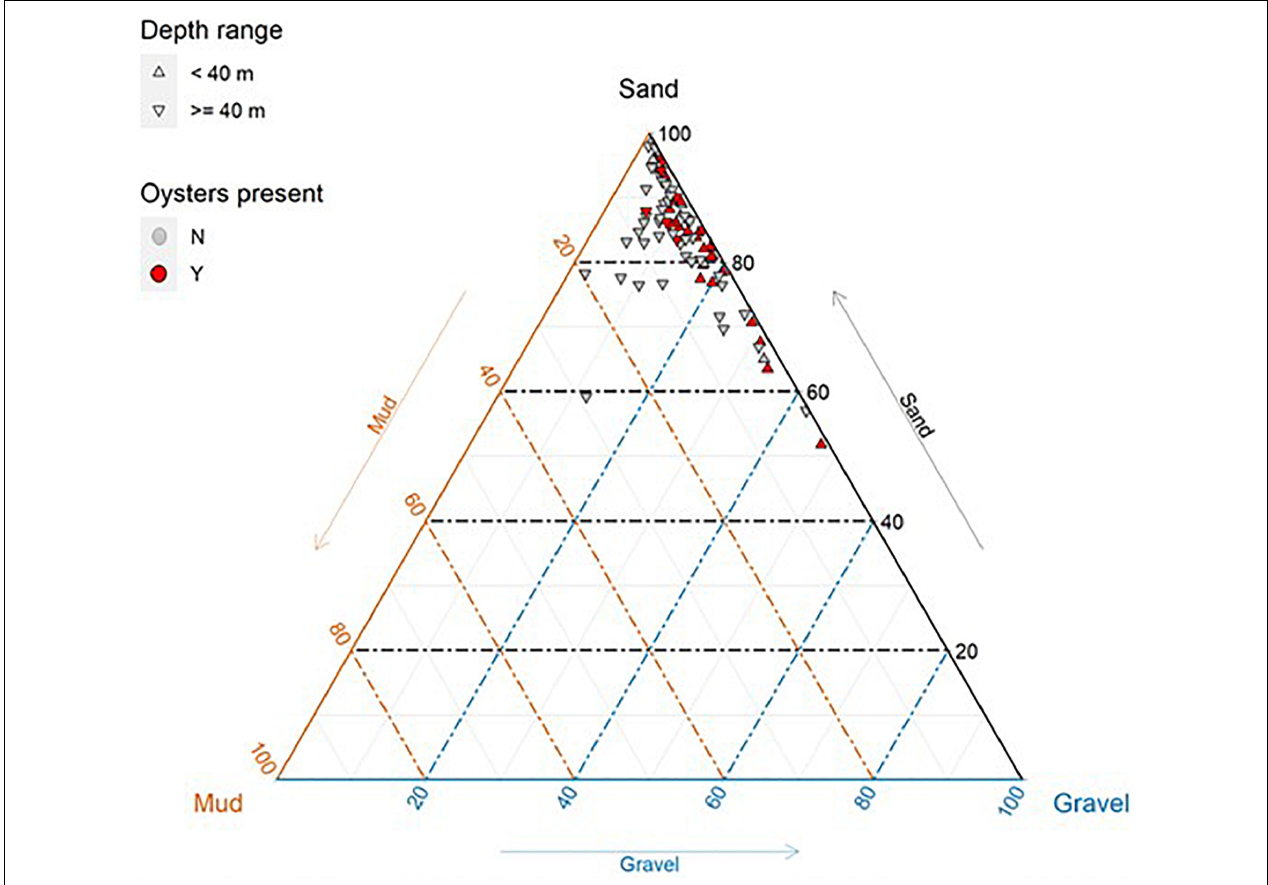
FIGURE 6 | Sediment composition (%) of benthic grabs ( n = 85) taken within the survey area offshore from Eighty Mile Beach. Sediment grabs located along transects where oysters were present are coloured red.